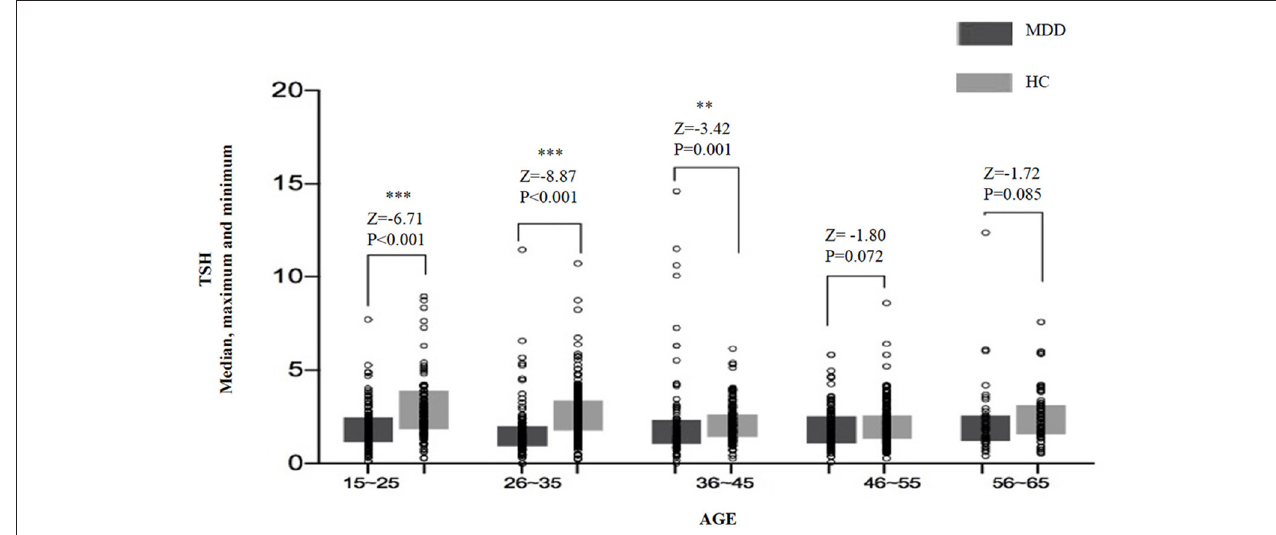
FIGURE 1 | The median, maximum, and minimum values of the TSH level ( IU/ml ) at different ages in the MDD and HC groups. * < 0.05, ** < 0.01.